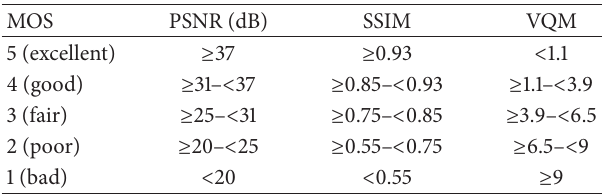
Table 2: Mapping among QoE metrics (SSIM, PSNR, VQM, and MOS) [16].